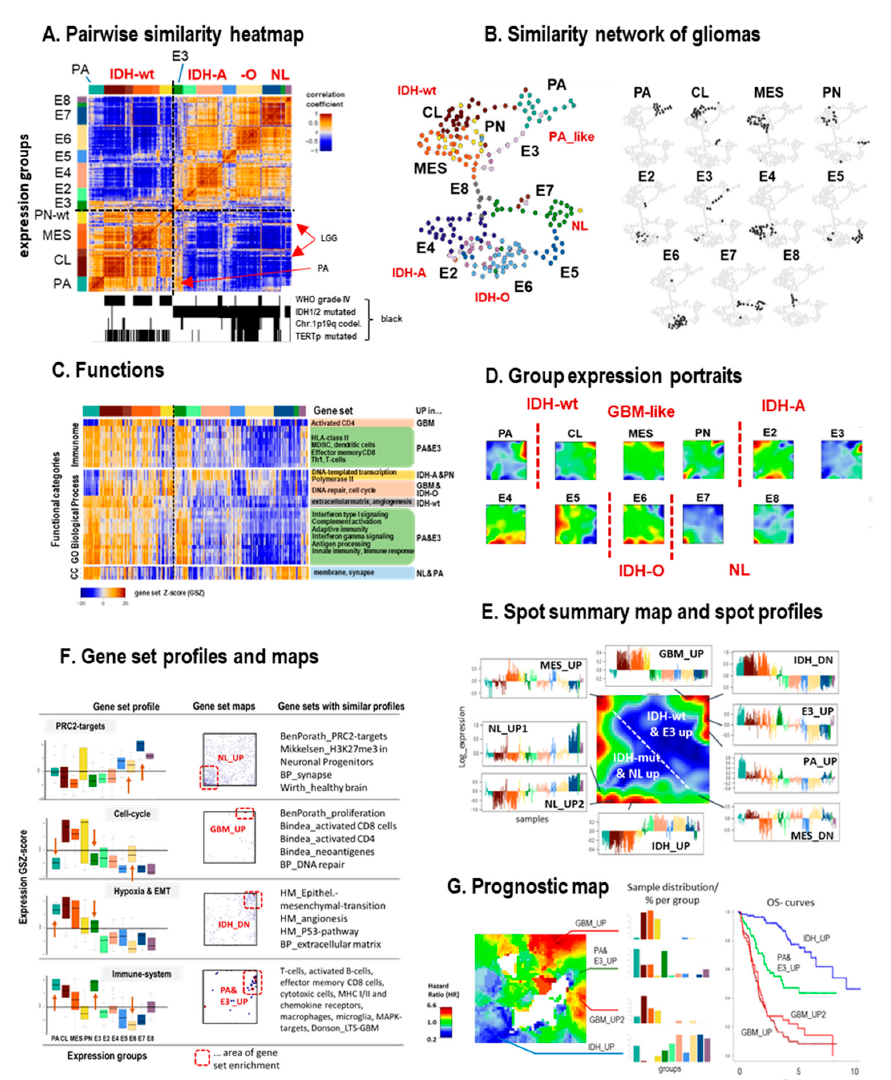
Figure 2. Cartography of ‘all-glioma’ transcriptomes considering pilocytic astrocytomas (PA) and IDH-wt, IDH-A, IDH-O, and neuronal (NL) gliomas of WHO-grade II- IV (see text): ( A ) The pairwise similarity heatmap reveals two major clusters formed by IDH-wt and IDH-mut (and NL) gliomas, respectively. The IDH-mut subgroup E3 reveals similarities with PA and, to a lesser degree, also with CL and MES IDH-wt (GBM-like) gliomas. ( B ) The similarity net visualizes mutual similarities between glioma specimen (dots). It separates virtually all subgroups (PA, CL, MES, and PN for IDH-wt and E2–E8 for IDH-mut). In the right part, samples of each group are separately colored in black. ( C ) Heatmap of expression profiles of selected gene sets indicate up- and downregulation in a subtype-specific fashion (see Supplementary File 1: Figures S1–S4 for details). ( D ) The SOM maps of the different expression groups ‘portrait’ their expression patterns in terms of up- (in red) and downregulated (in blue) gene clusters. Note that each group is characterized by a unique ‘fingerprint’ expression portrait. ( E ) The overexpression summary map provides an overview about the spots upregulated in any of the groups, as illustrated by selected expression profiles. They indicate upregulation of the respective genes in a subtype-specific fashion. For example, ‘E3_UP’ assigns a spot that specifically upregulates in group E3 and partly in PA (see also the group portraits of E3 and PA in part D). ( F ) Box plots of the group-related expression of selected gene sets reveal characteristic effects. While PRC2 targets (and healthy brain functions) loose expression in gliomas compared with the NL subtype, cell cycle activity, immune response, and hypoxia (and EMT, epithelial mesenchymal transition) functionalities gain in expression, especially in IDH-wt gliomas. Interestingly, PA and E3 concertedly change in virtually all situations (see arrows). The gene set maps indicate accumulation of the genes of the respective set (shown by dots) in distinct areas of the map. Gene sets were taken from the literature [41–43,57]. ( G ) The prognostic map colors areas in which upregulation of the respective genes associates with high (red) or low (blue) hazard ratio (HR). The barplots show the composition of groups expressing the respective genes together with the respective overall survival curves (see Figure S7 for